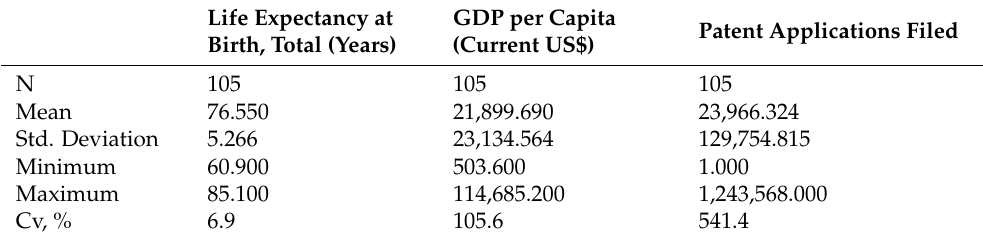
Table 2. Descriptive Statistics.